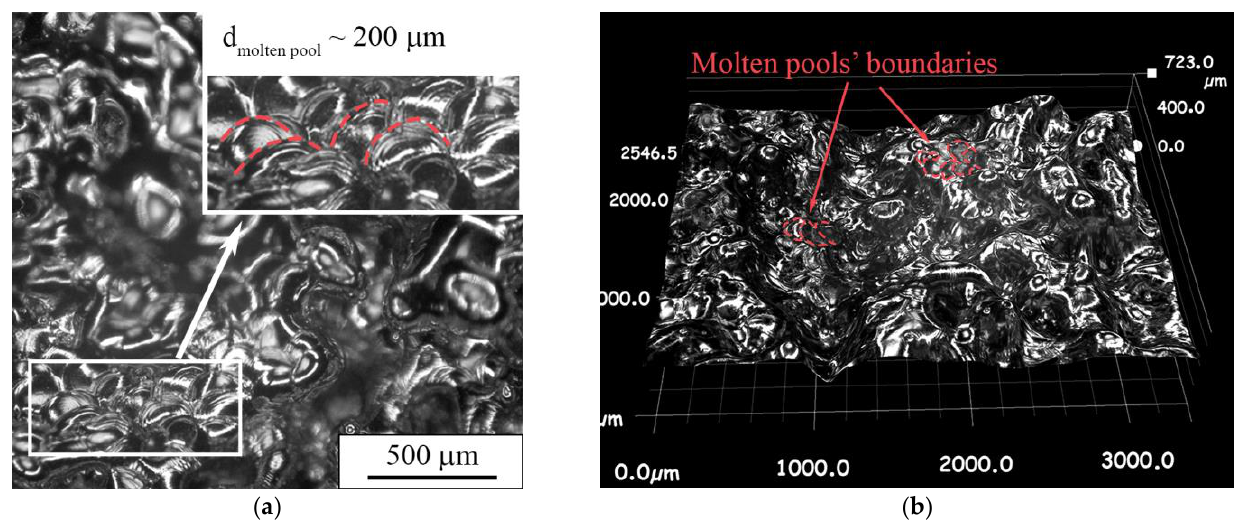
Figure 13. Multifocal digital image of a porous sample’s top surface in ( a ) 2D and ( b ) 3D mode.